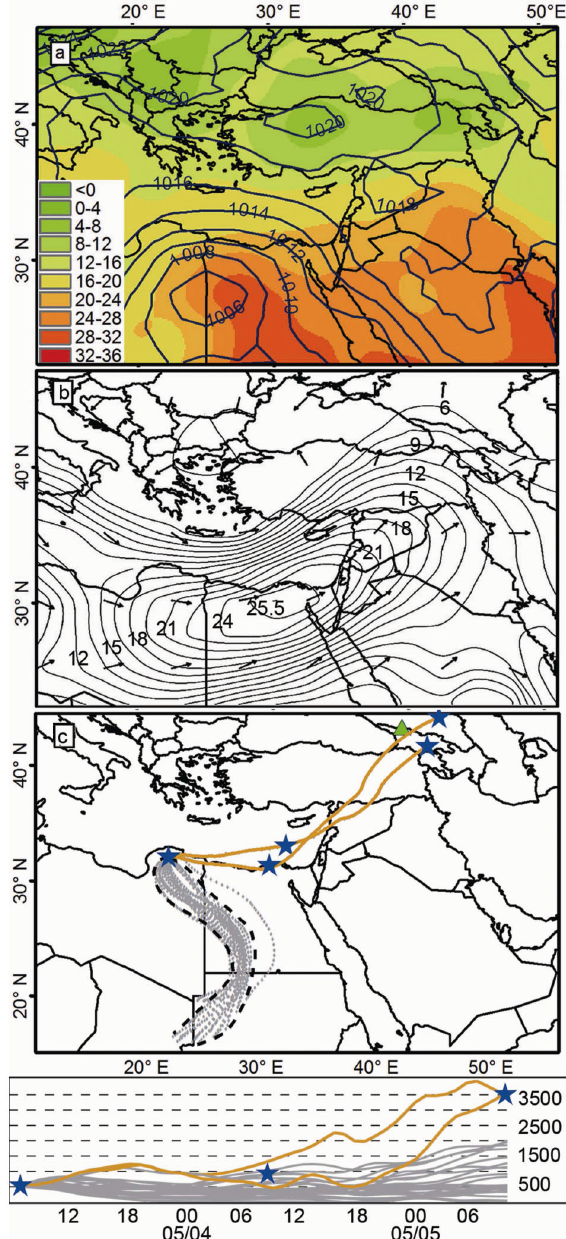
Fig. 1. NCEP/NCAR re-analyses of (a) SLP (hPa) and surface tem- perature ( ◦ C) at 06:00UTC, 3 May 2009; (b) daily average wind speed (ms − 1 ) and direction at 700hPa on 4 May 2009; (c) 2-day three-dimensional forward trajectories from HYSPLIT model start- ing at 32.0144 ◦ N, 22.27333 ◦ E; 500m above the model earth sur- face at 10:00UTC on 3 May 2009. Star signs on (c) mark 24-h in- tervals; Mt. Elbrus is marked as triangle. Members of trajectory en- semble travelling south are shown in grey; those travelling towards the Caucasus are shown in